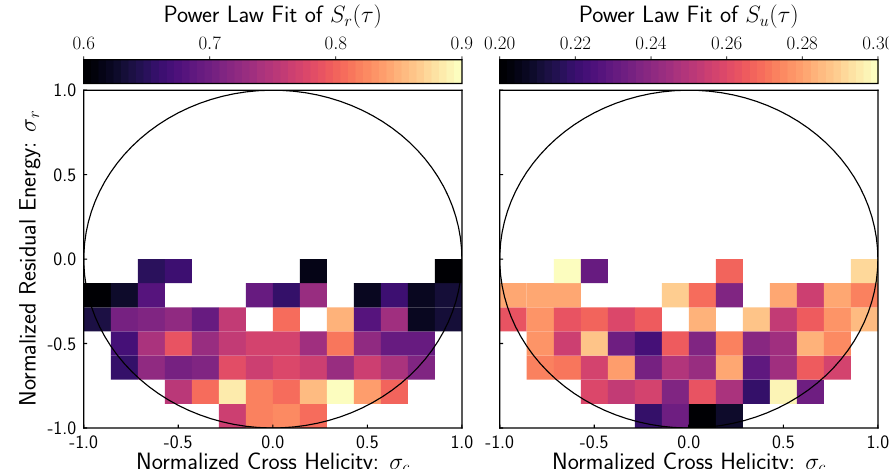
Figure 2. Bins, conditioned on the normalized cross helicity and normalized residual energy show the exponents of power law fits to structure functions. The structure functions correspond to definitions in the